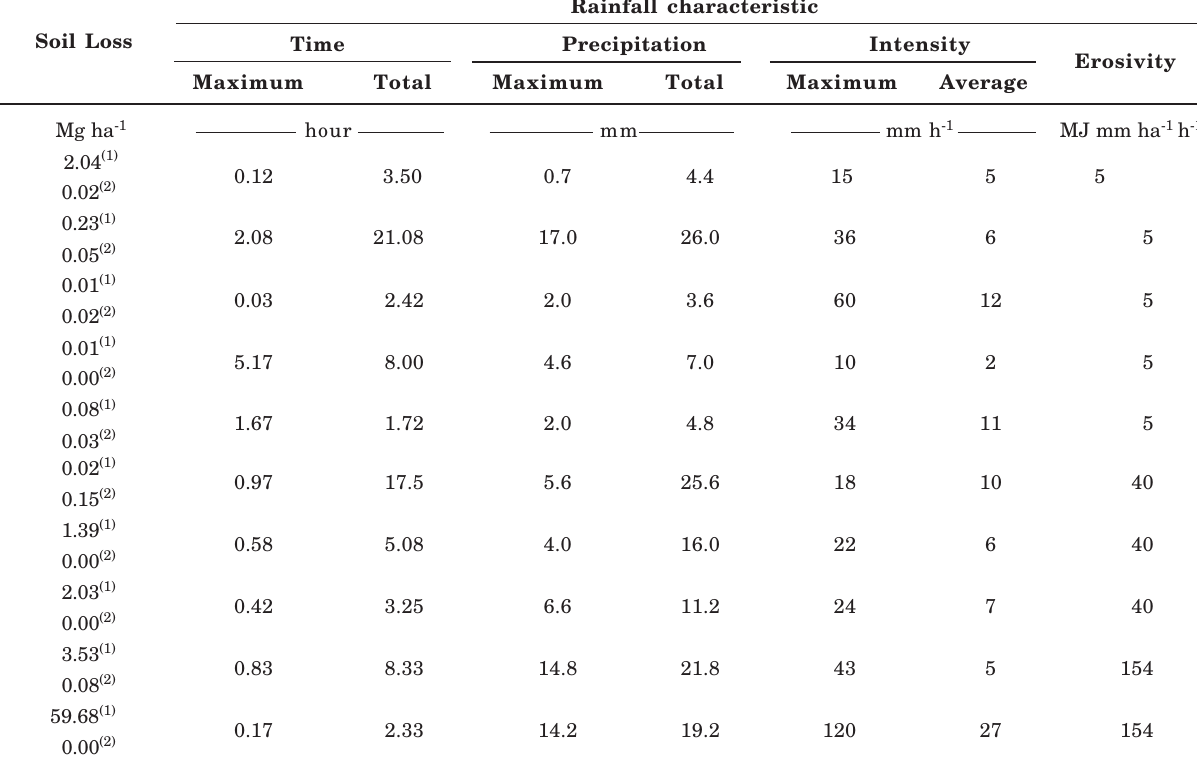
Table 4. Soil loss related to rainfall events with similar characteristics in the region of Lavras,